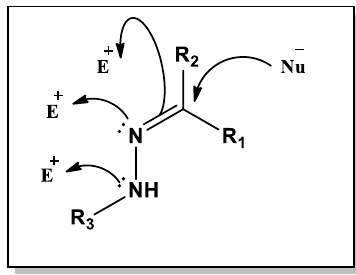
Figure 1. Structure and reactivity of hydrazones .